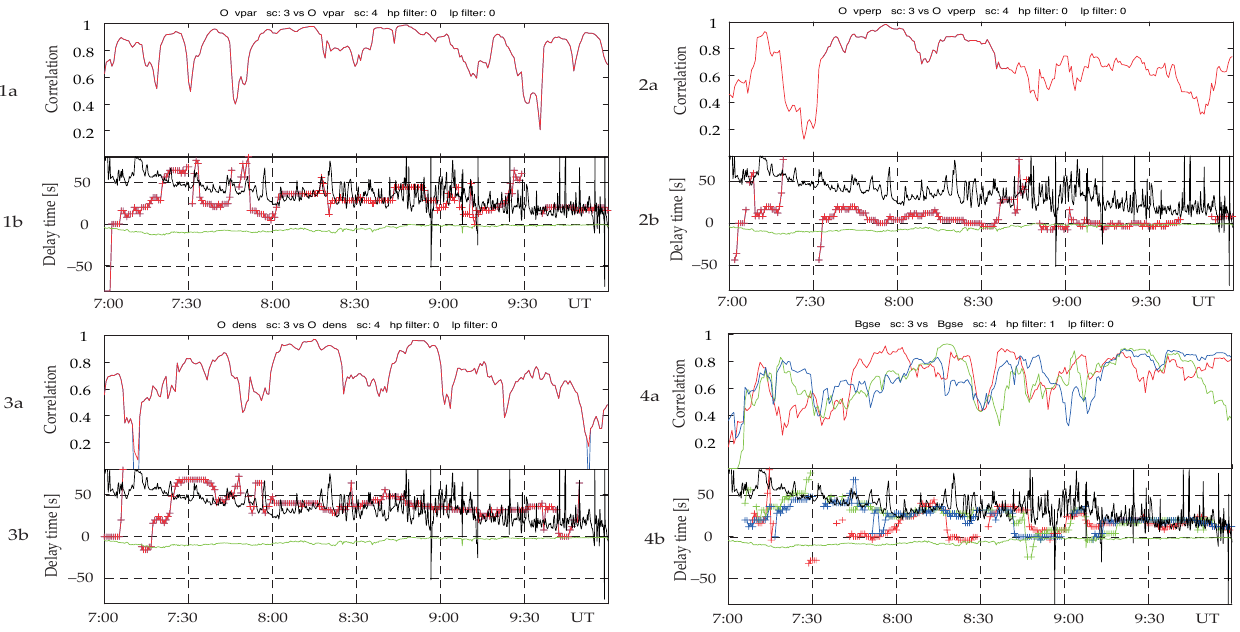
Fig. 6. Cross-correlation results with spacecraft 3 leading spacecraft 4. The correlation window was 160 lags (approximately 10min). The (a) panels show cross-correlation coefficients, whereas the (b) panels show time delay for maximum correlation (red crosses), the time delay expected due to convection (black line) and field-aligned flow (green line). Panels 1 show correlation results for O + parallel velocity, 2 perpendicular velocity, and 3 density. In panel 4a is shown the correlation coefficient for the magnetic field components, blue is for B x , green B y and red B z (GSE coordinates). Panel 4b uses the same colour code for the delay